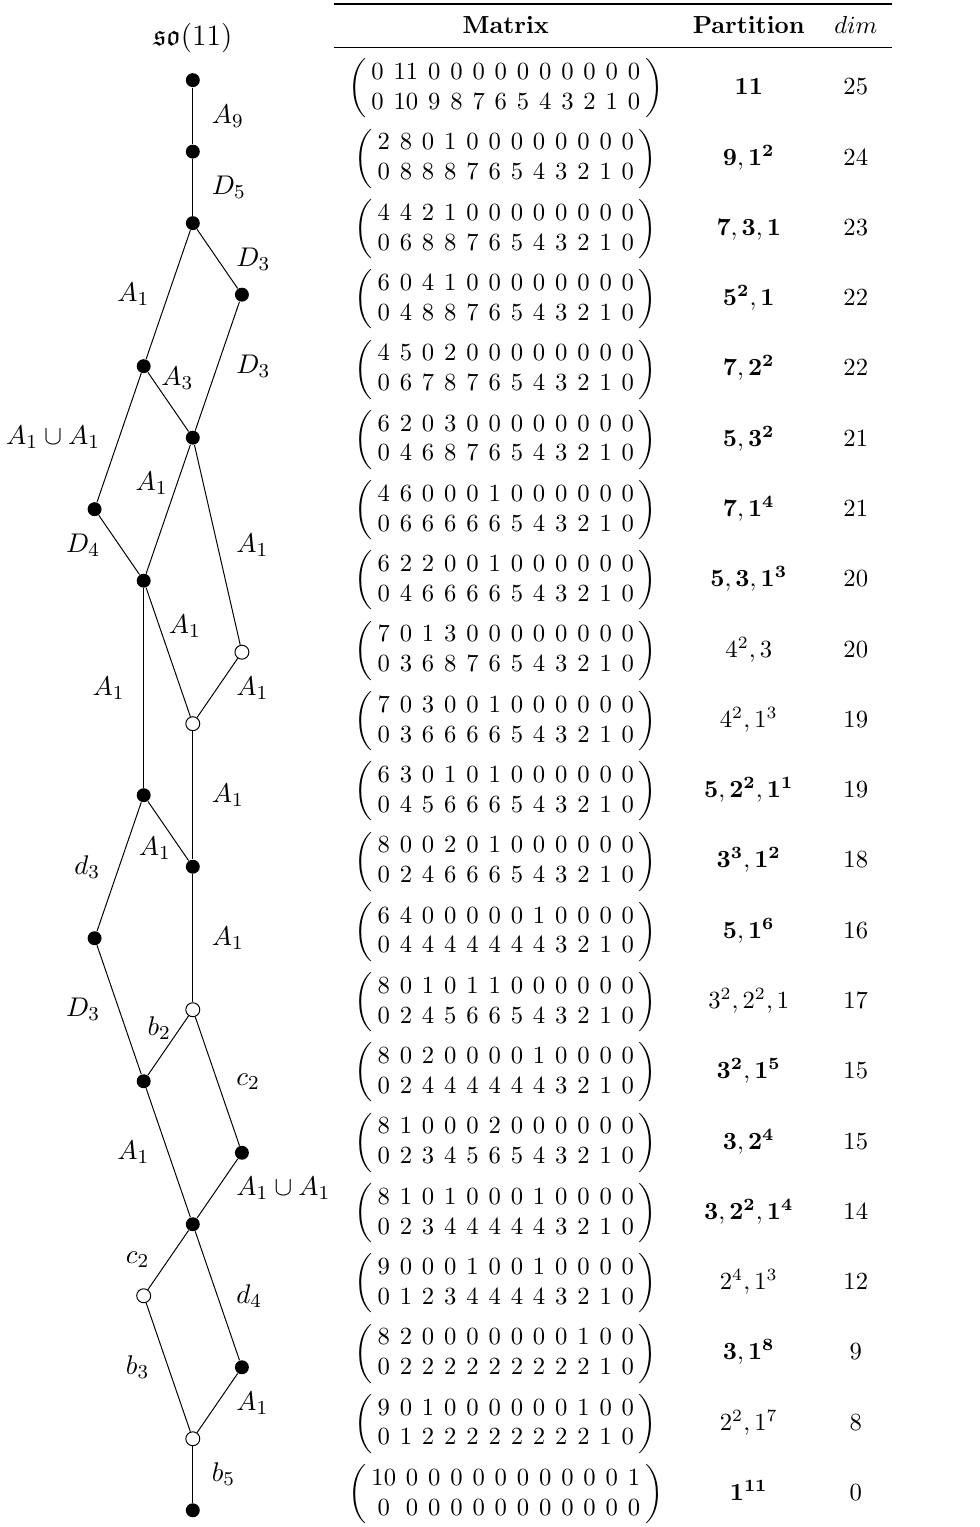
Table 18. Results obtained applying the matrix formalism to so